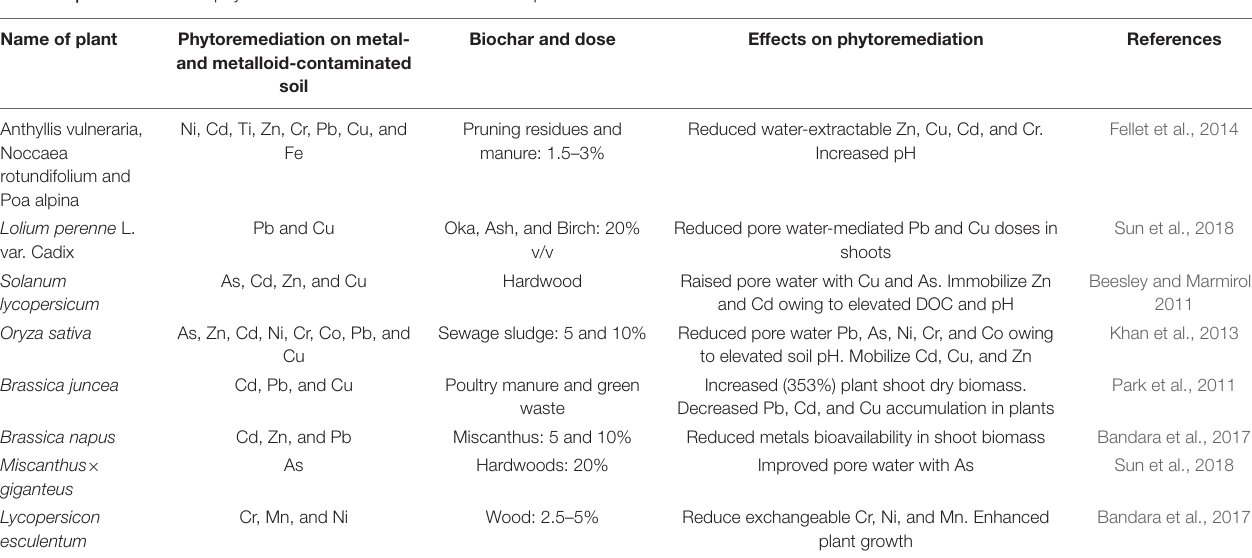
TABLE 2 | Biochar-assisted phytoremediation for metal- and metalloid-polluted